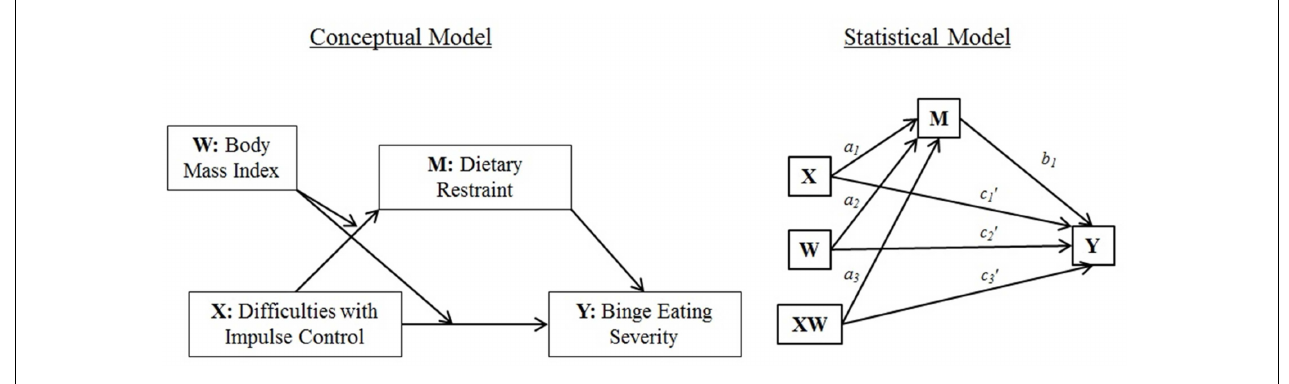
FIGURE 1 | Conceptual and statistical moderated mediation model [adapted from (Hayes, 2012)]. TABLE 1 | Demographics, body mass index, and mean scores on the difficulties in Emotion Regulation Scale, Dutch Eating Behavior Questionnaire, and the Binge Eating Scale in under- and normal-weight versus overweight and obese respondents. Total Under/Normal Over/Obese